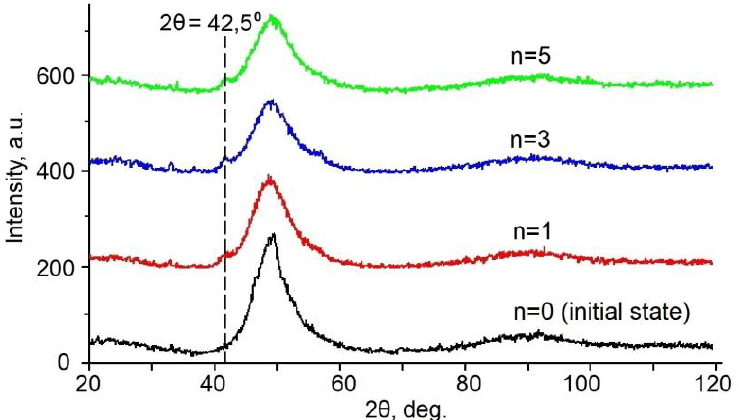
Figure 5. XRD patterns of the TiNiCu alloy with 34 at.% Cu in the initial state and after HPT to n = 1, 3, and 5.